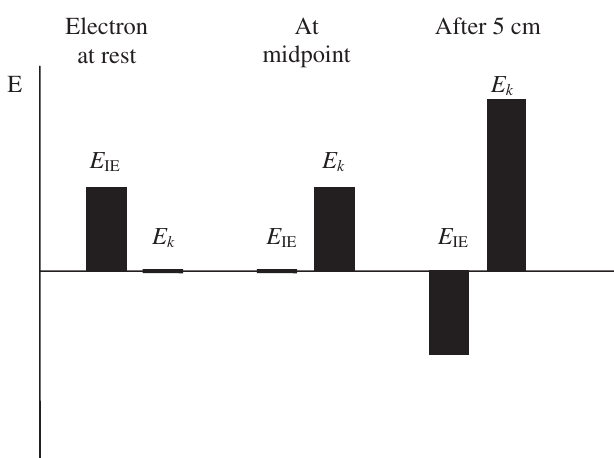
FIG. 3. Example of energy bar